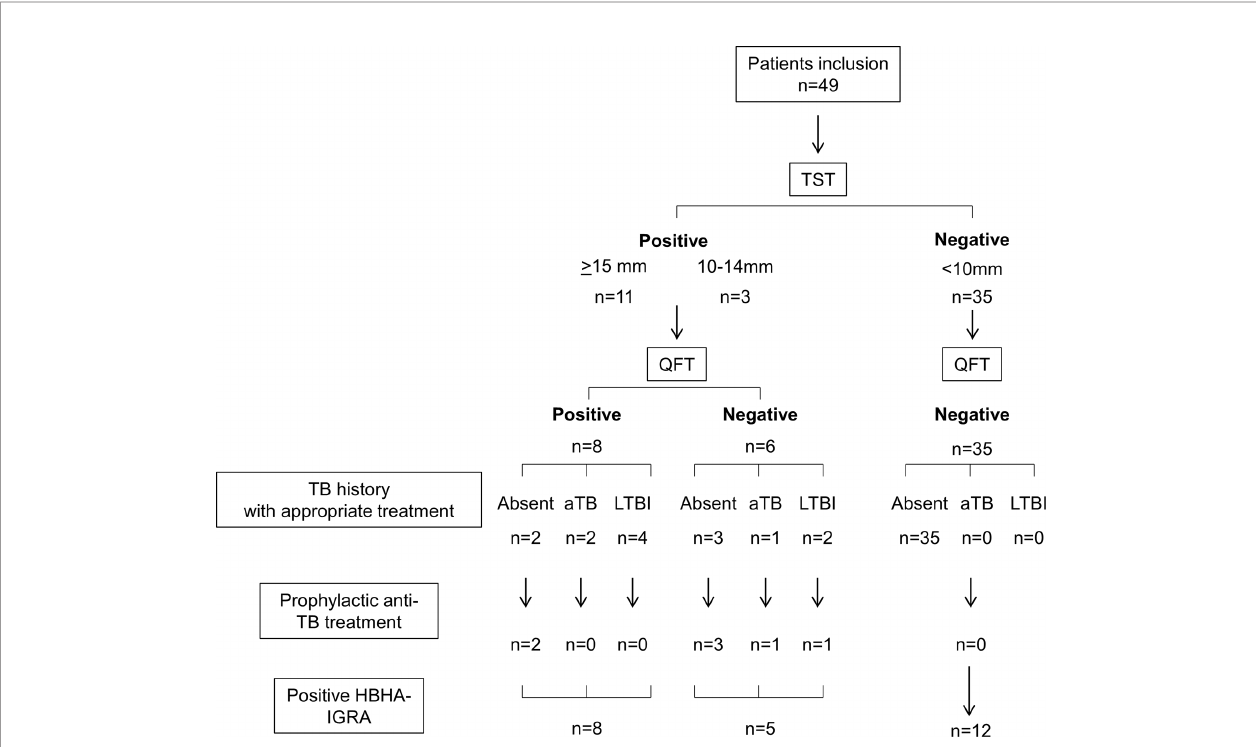
FIGURE 1 | Algorithm of the patients ’ classi fi cation. n, number of patients; TST, tuberculin skin test; QFT, QuantiFERON TB Gold In tube; TB, tuberculosis; HBHA-IGRA, Heparin-binding haemagglutinin-interferon-gamma release